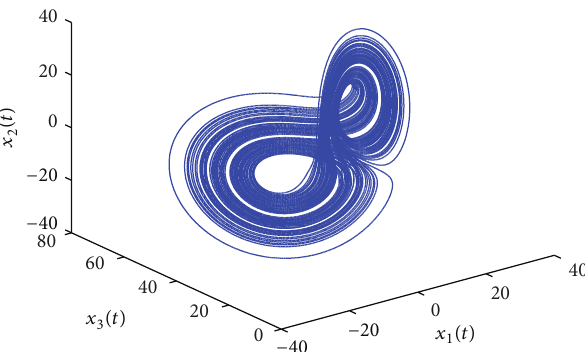
Figure 1: Chaos phase portrait of the time-delayed Lorenz